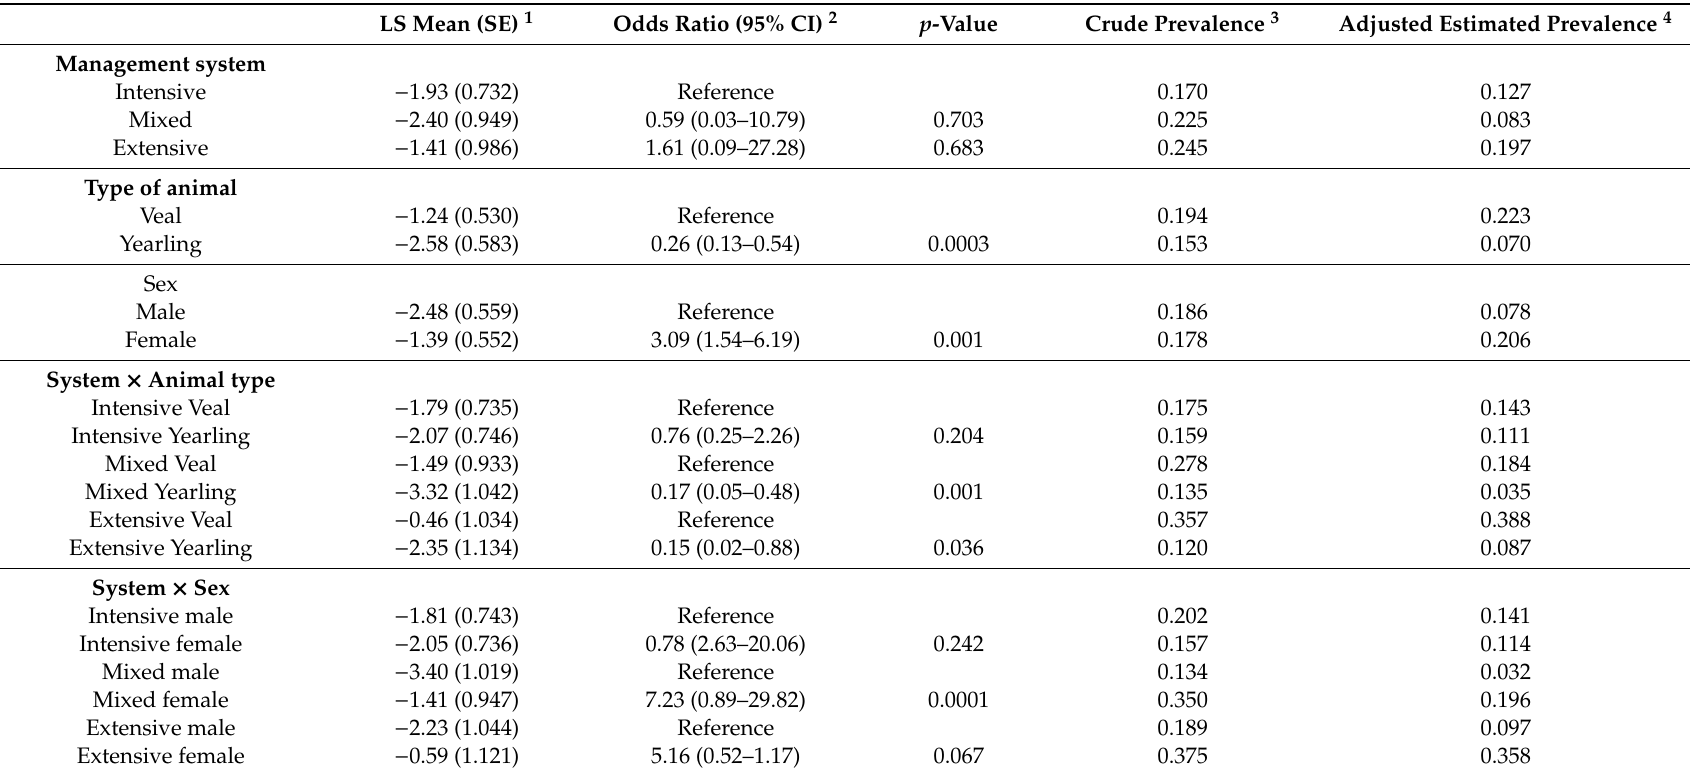
Table 2. Parameter estimates (for an average farm) of the multilevel random intercept model predicting log odds of pneumonia (log-probability of pneumonia / probability of being healthy) and crude and conditional estimated prevalence of